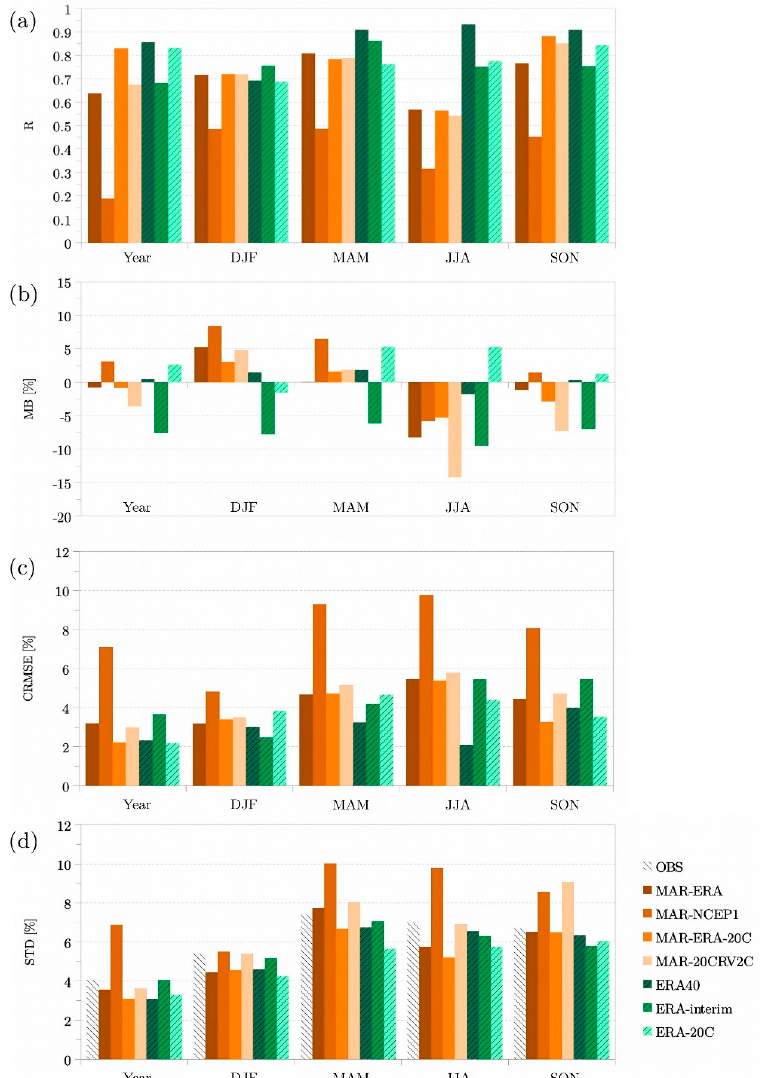
Figure 5. Modelled TCC vs. observed TCC at Saint-Hubert for 1966–2010: ( a ) annual and seasonal correlation (R); ( b ) mean bias (MB); ( c ) centred root mean squared error (CMRSE); and ( d ) standard